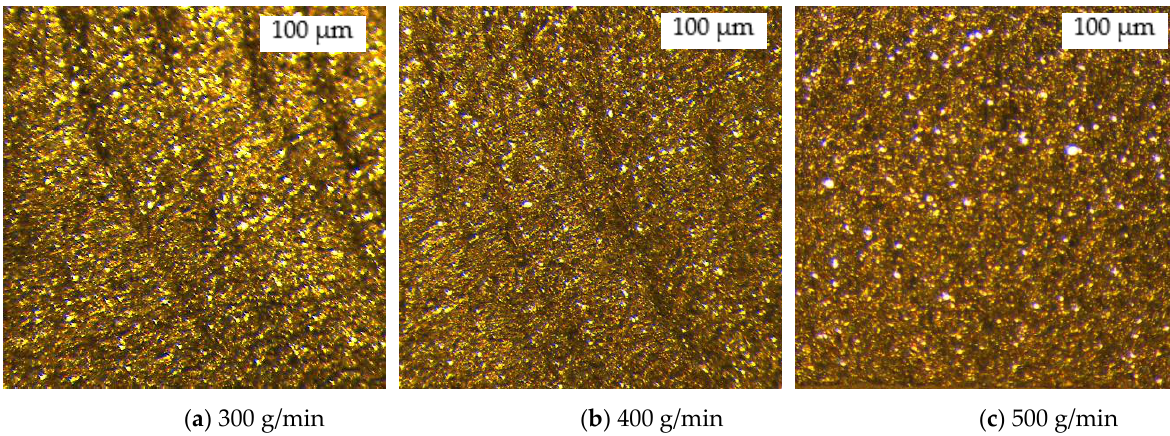
Figure 9. Topography of AISI 304L cut surface with 12 mm thickness using varied waterjet pressure.